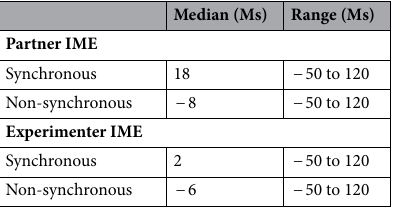
Table 2. Descriptive statistics for the imitation effect in the automatic imitation task.